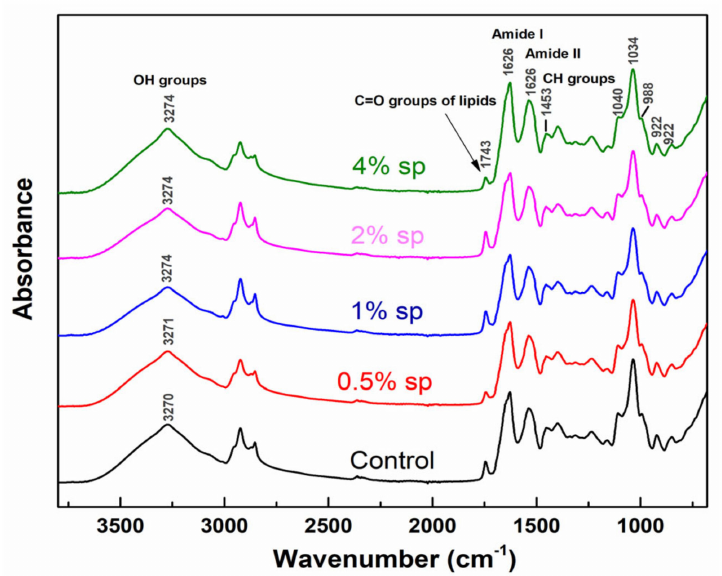
Figure 2. ATR-IR absorbance spectra of WPC-based films (control: corresponds to films without sp., 0.5; 1; 2 & 4% sp.: correspond to films incorporated with different concentrations of sp.